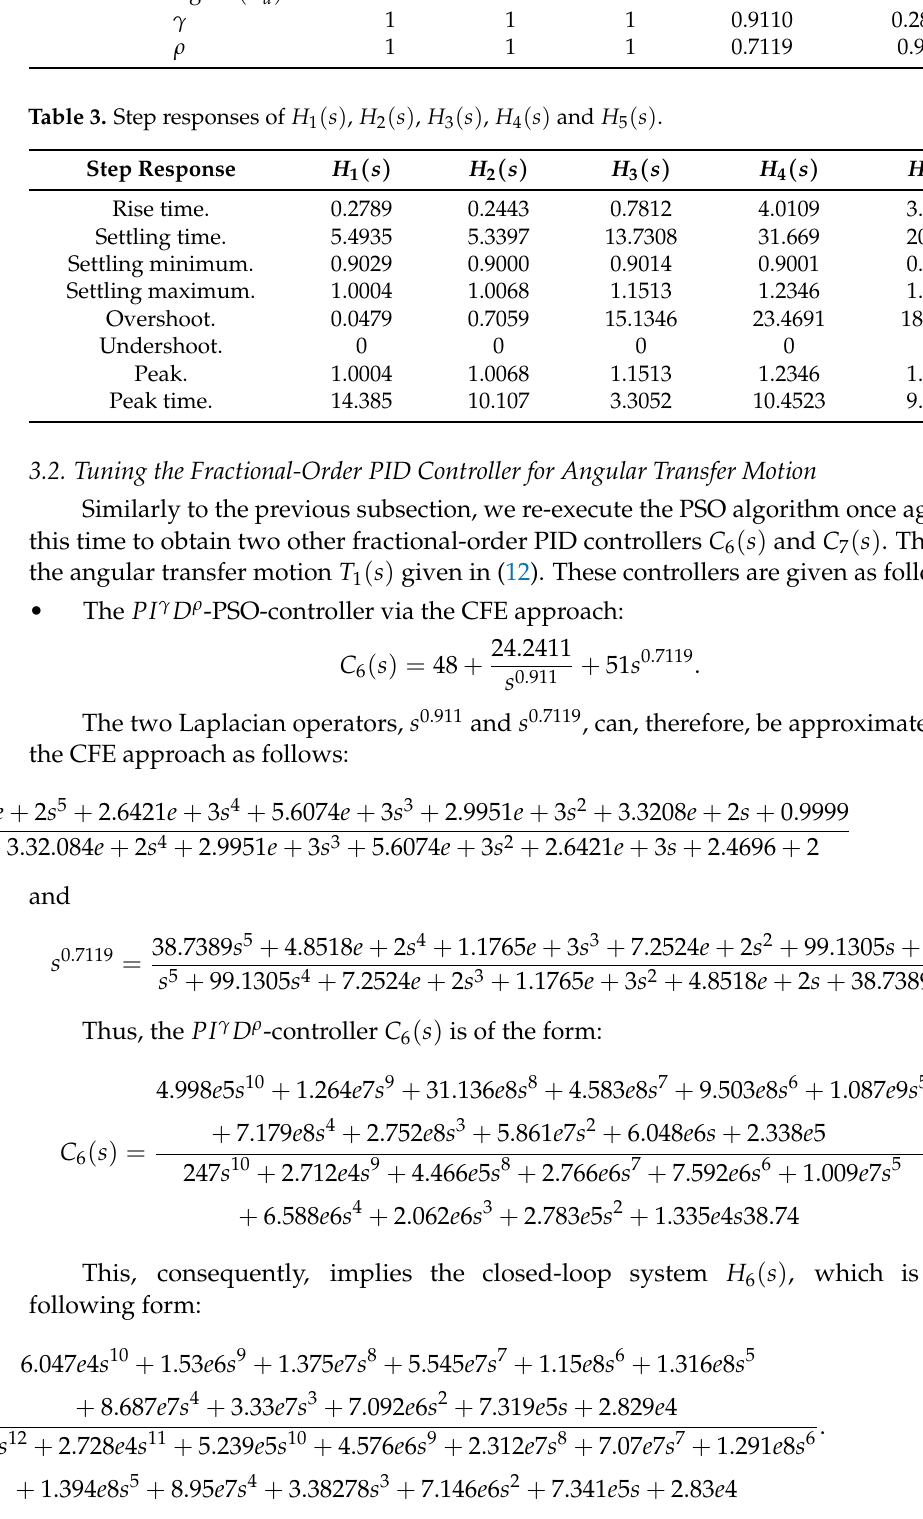
Table 2. The gains of PID and fractional-order PID controllers for linear vehicle motion. Gains/Methods ZN CC BFA CFE Oustaloup Proportional gain ( K p ) . Integral gain ( K i ) .